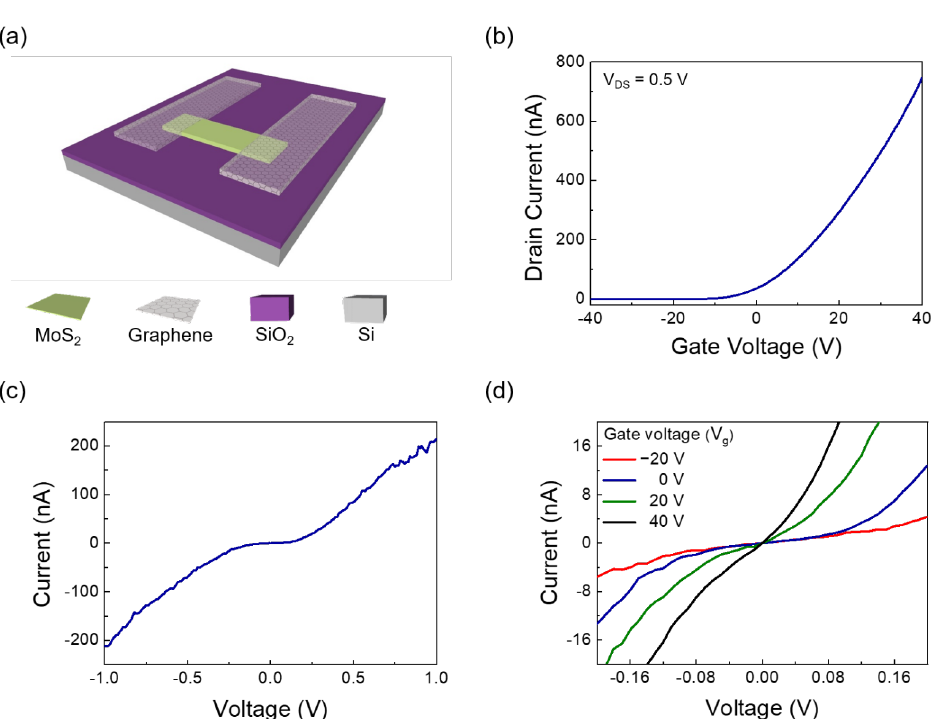
Figure 5. Schematic and electrical properties of MoS 2 FET with graphene electrodes. ( a ) Schematic of MoS 2 FET with graphene electrodes; ( b ) I DS –V g transfer characteristics at V DS = 0.5 V; ( c ) I DS –V DS output characteristics; ( d ) I DS –V DS characteristics at different gate bias voltages.